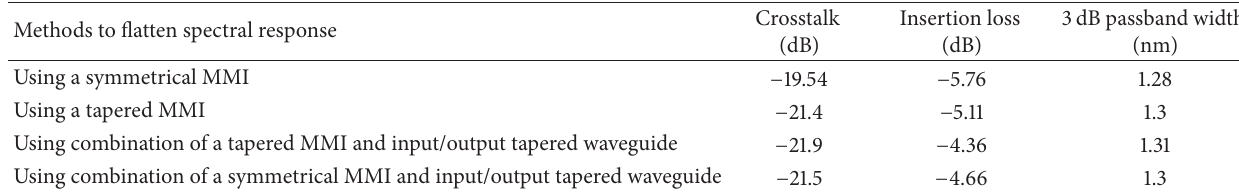
Table 2: Comparison of the four